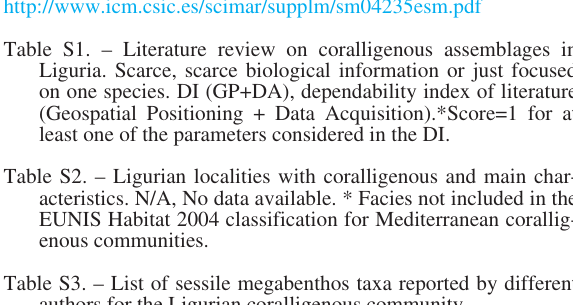
Table S1. – Literature review on coralligenous assemblages in Liguria. Scarce, scarce biological information or just focused